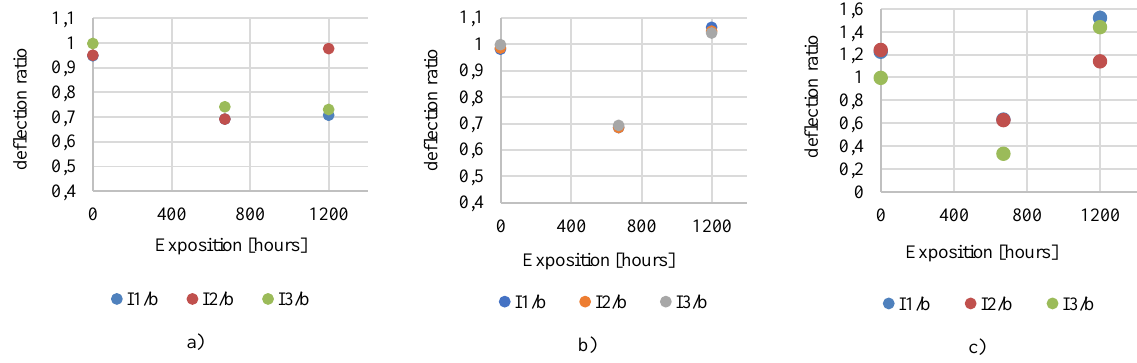
Fig. 6 Ratio between deflection of I1 I2 I3 specimens and average deflection of specimens B as a function of exposition time to UV radiation: a) elastic share of deflection; b) total deflection; c) delayed